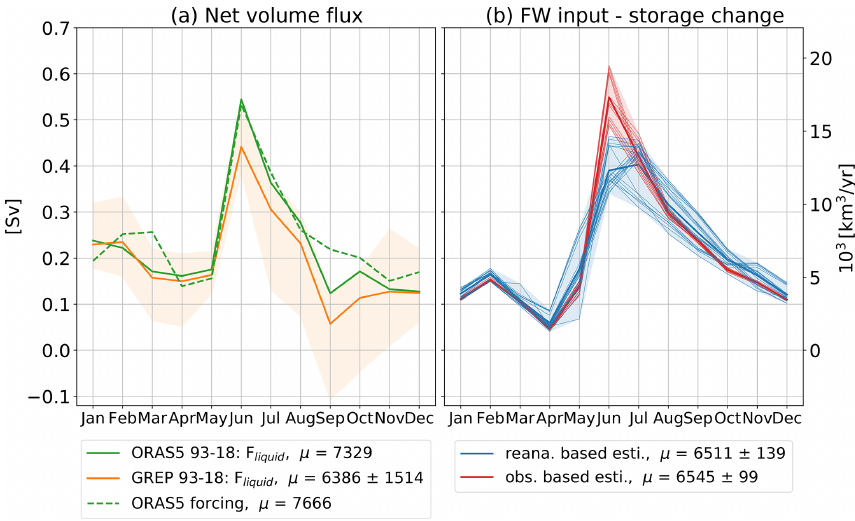
Figure 9. (a) Mean seasonal cycles of lateral net volume fluxes (defined as positive out of the Arctic) from ORAS5 (1993–2018) and GREP (1993–2018) as well as the sum of forcing terms generating ORAS5. (b) Different realizations of observation- and reanalysis-based estimates of freshwater input minus oceanic storage for the period